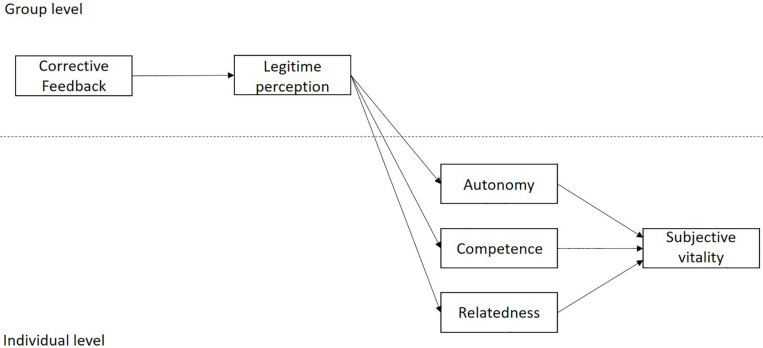
Graphical representation of the hypothesized conceptual model.